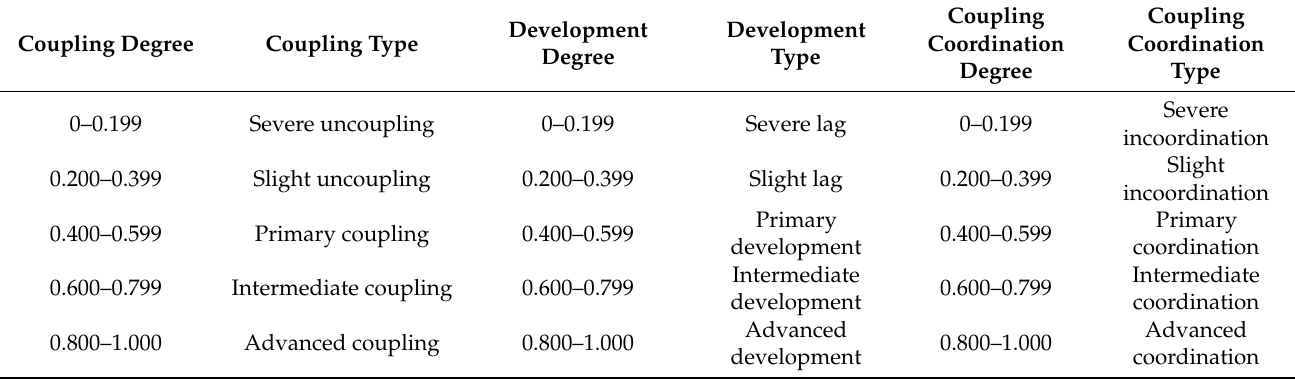
Table 4. Grade division standard for coupling degree, development degree, and coupling coordination